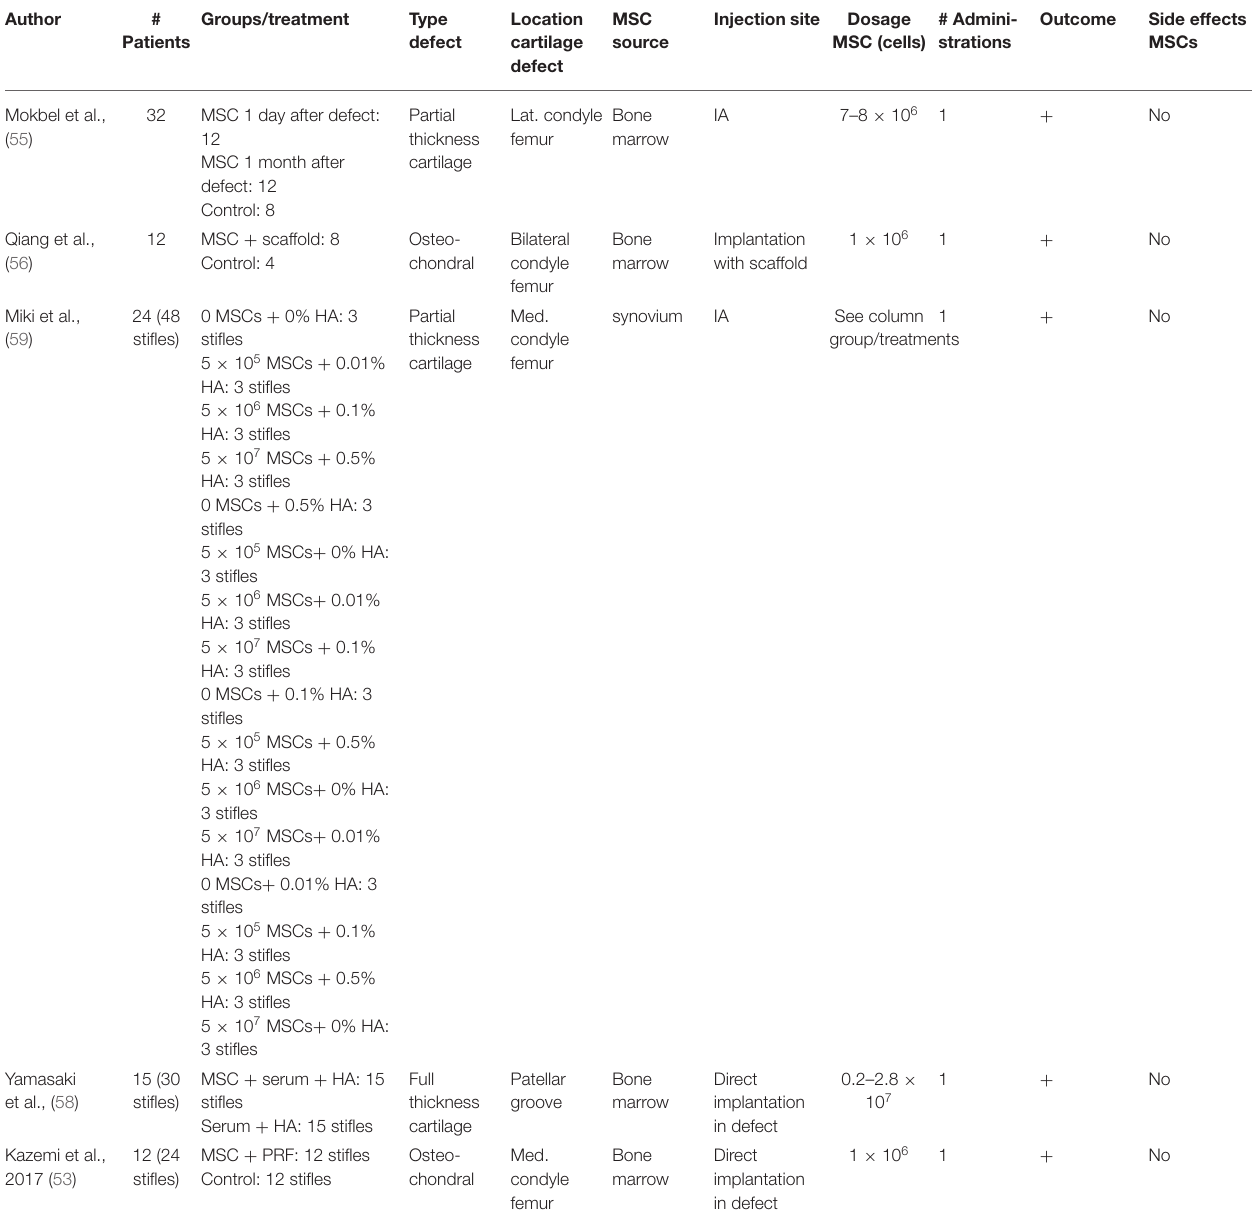
TABLE 4 | Chronologic presentation of model based studies applying autologous